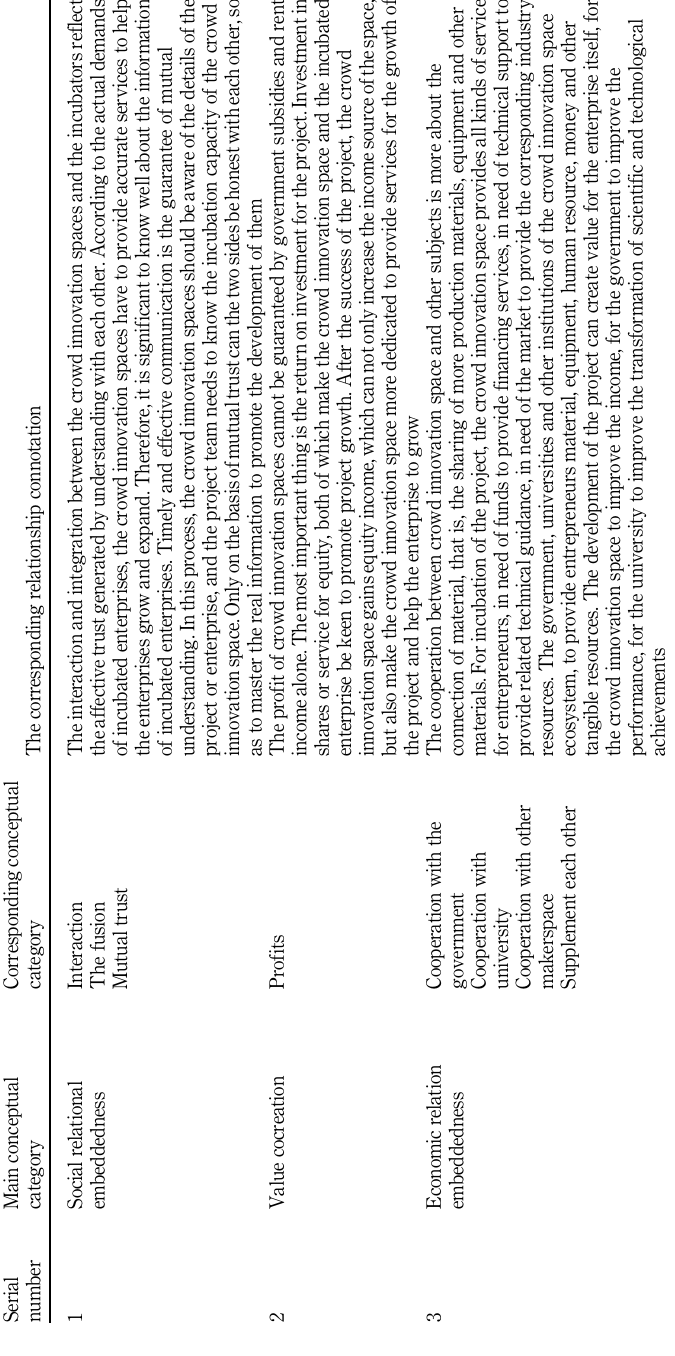
Table 4. Axial coding of ecosystem operation mechanism of crowd innovation